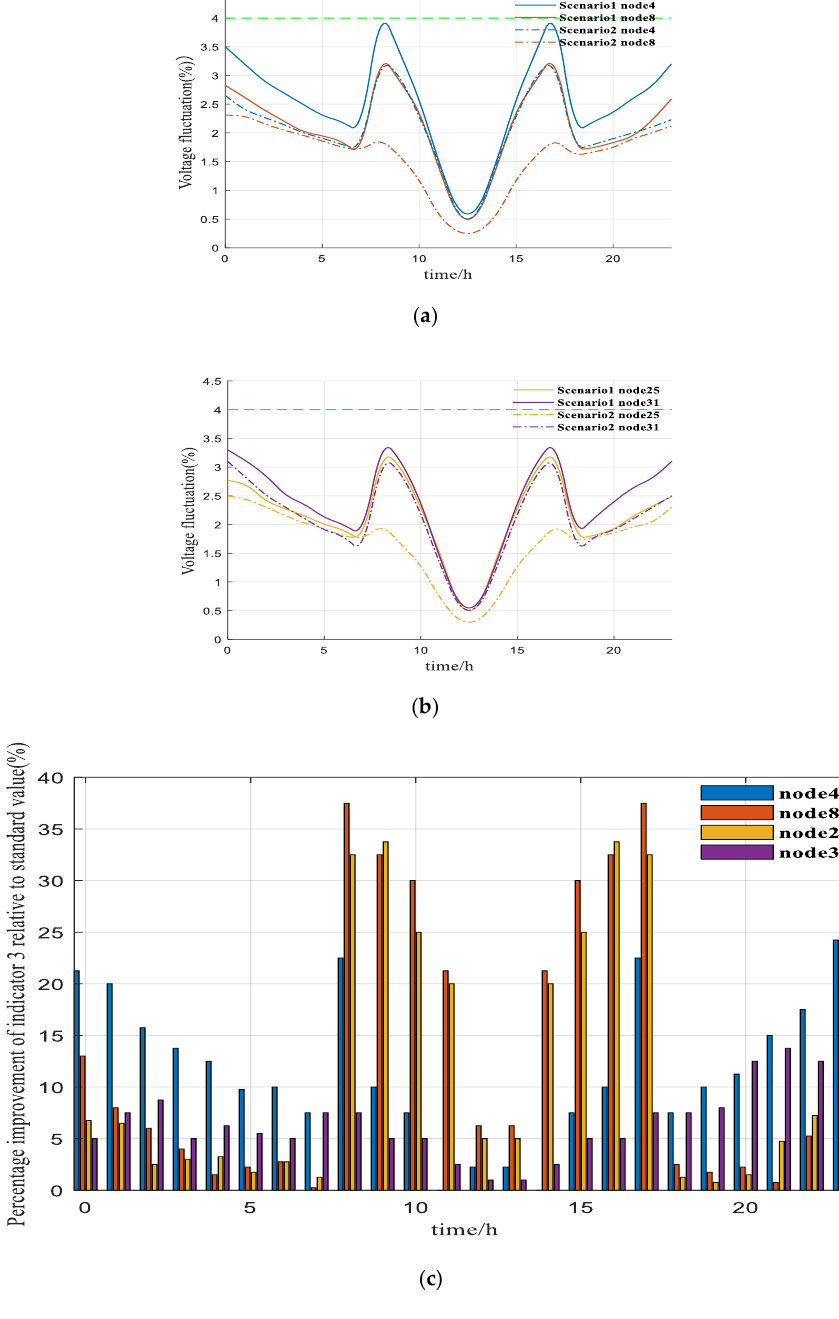
Figure 9. Voltage fluctuation curve. ( a ) Comparison of sub-scenarios of nodes 4 and 8. ( b ) Comparison of sub-scenarios of nodes 25 and 31. ( c ) Percentage improvement of voltage fluctuation relative to standard value.